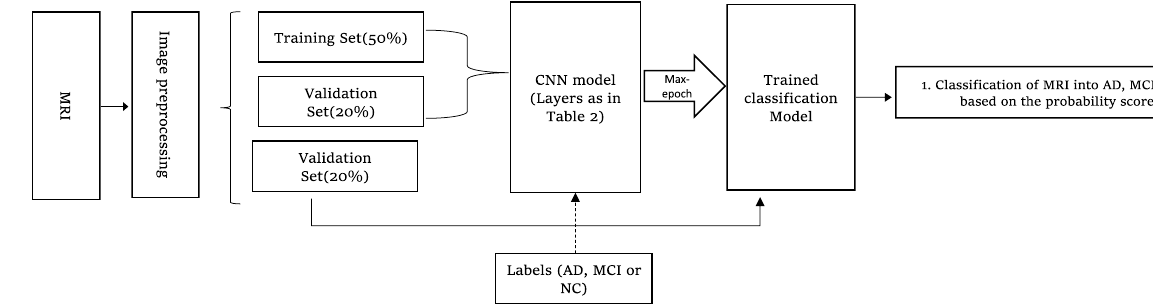
Figure 4. Block diagram for proposed method.